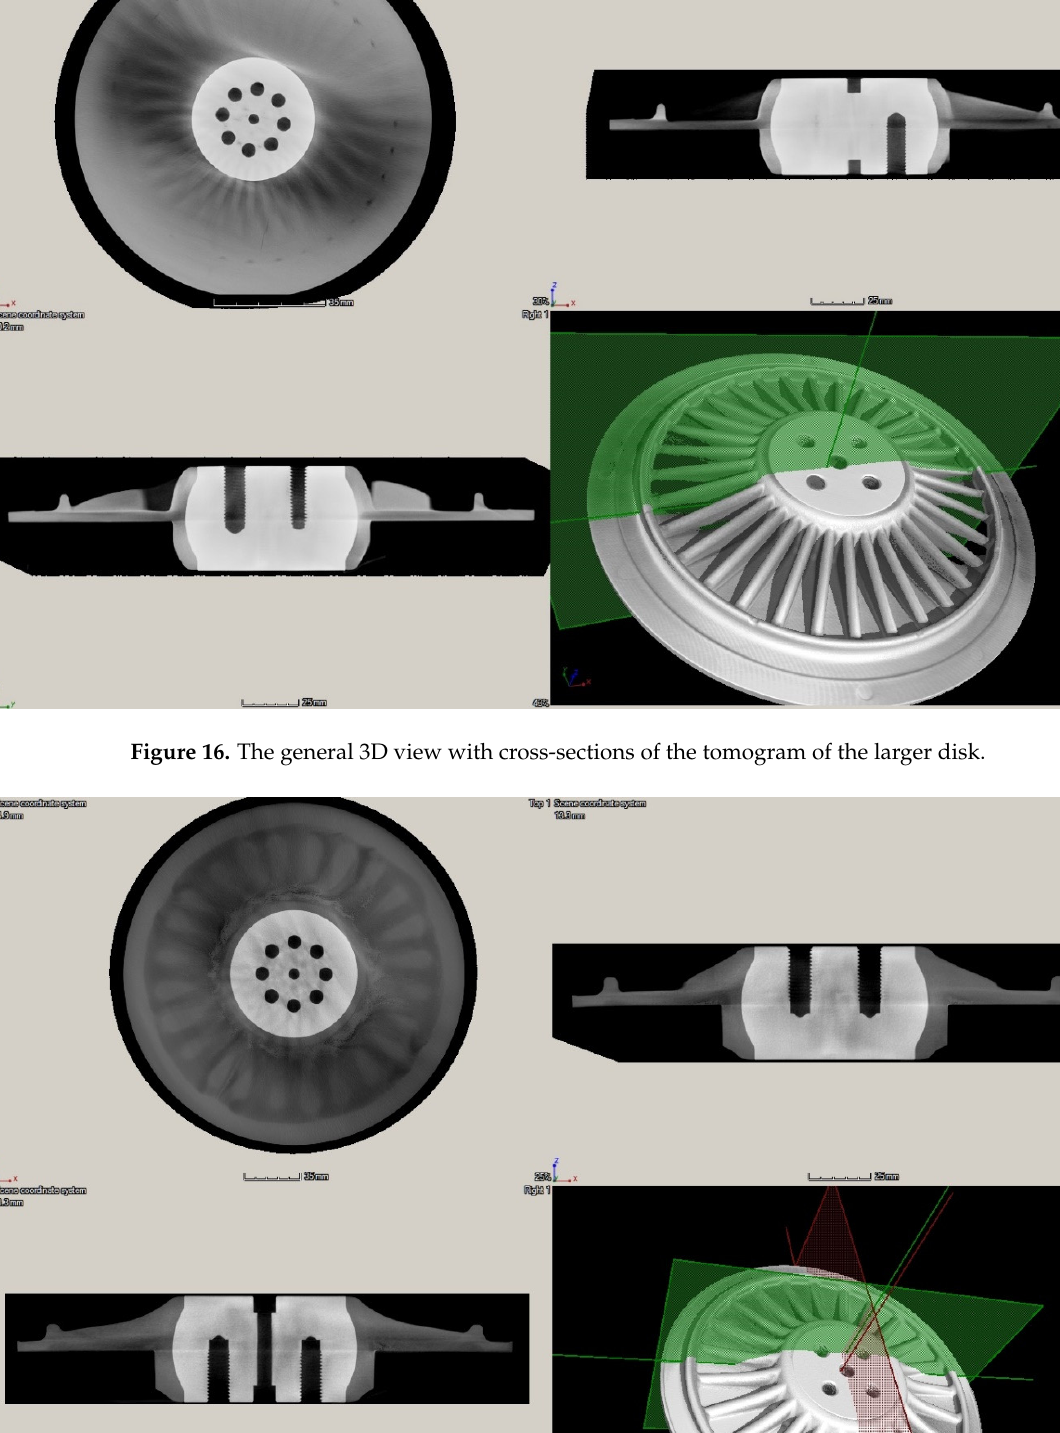
Figure 18. The selected detailed views of the tomogram of the larger disk with dimensioned lower density areas.